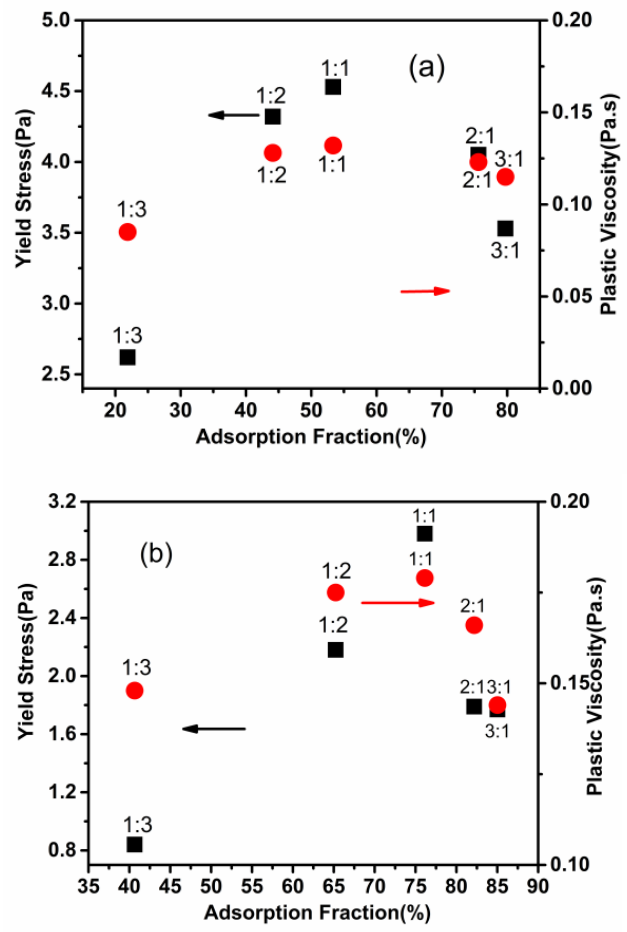
Figure 8. Correlation between rheological parameters and adsorption fraction: ( a ) 5 min, ( b ) 90 min. Black square represents yield stress. Red circle represents plastic viscosity.